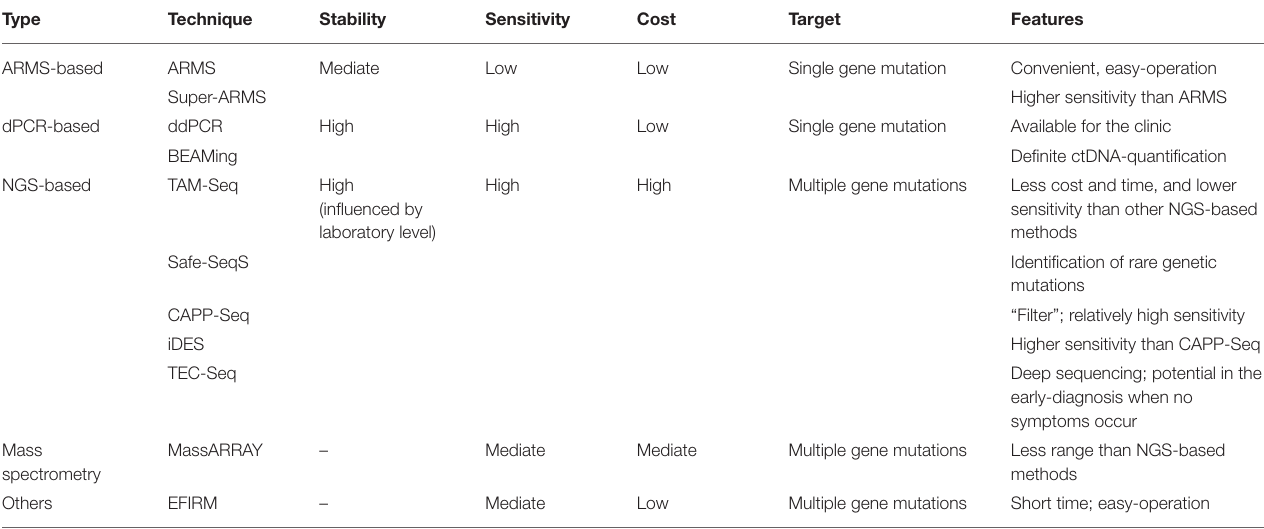
TABLE 3 | The comparison of various ctDNA detection